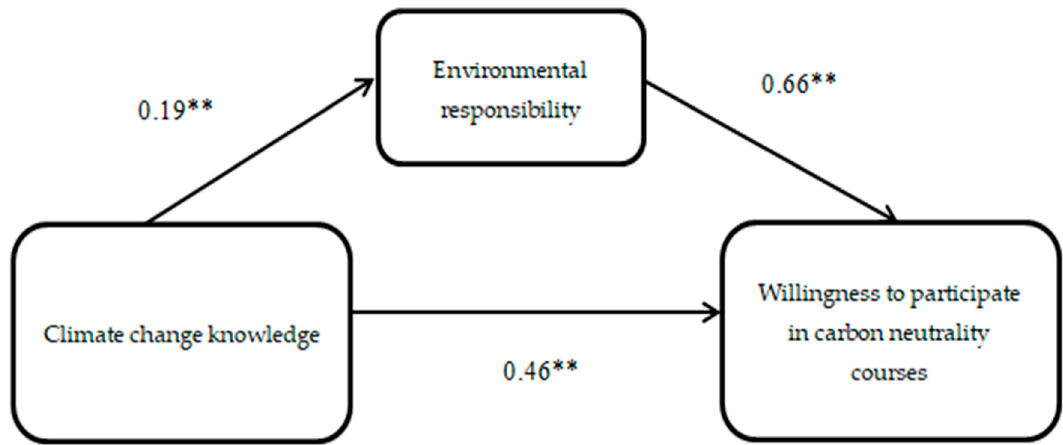
Figure 3. Model of willingness to participate in carbon neutrality courses. Note: ** p < 0.01.